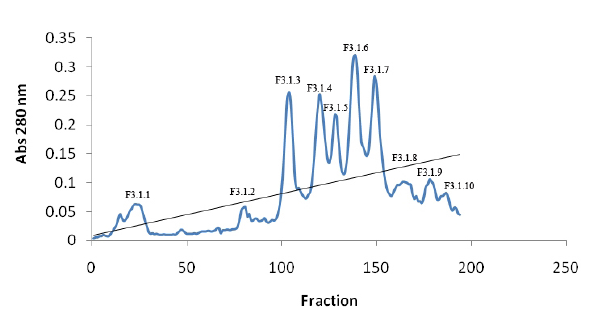
Table 3. Killing effect of F3.1 fraction obtained by cation-exchange chromatography with CM resin Killing effect Killing effect Peak in mouse 1 in mouse 2 F3.1.1